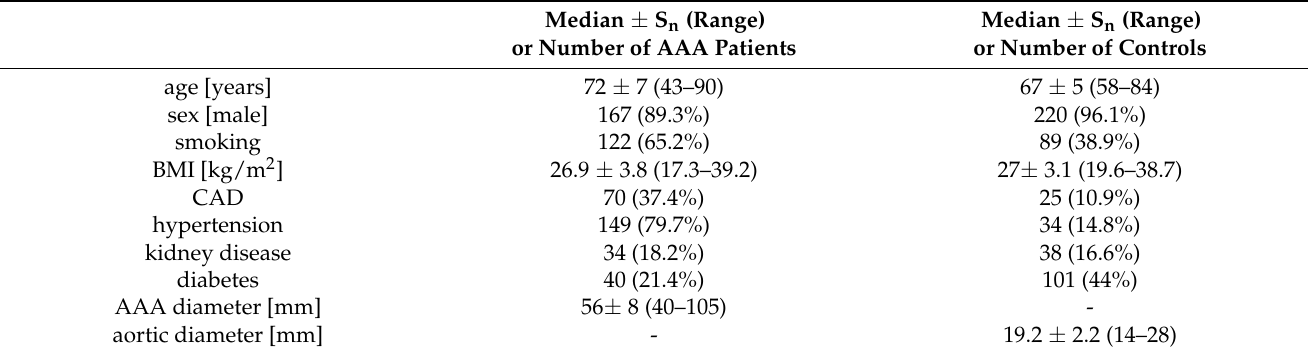
Table 1. Demographic and clinical characteristics AAA patients ( n = 187) and control subjects ( n = 229). Median ± S n